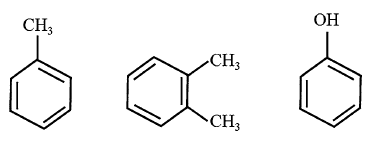
Fig. 2 Molecular structure of toluene, xylene, and phenolic acid